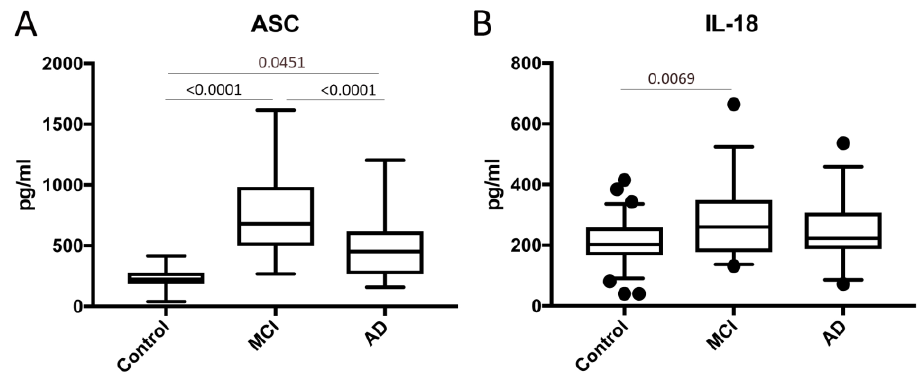
Figure 1. Apoptosis-associated speck-like protein containing a caspase recruitment domain (ASC) and interleukin (IL)-18 are elevated in the serum of patients with mild cognitive impairment (MCI) and Alzheimer’s disease (AD). Protein levels in pg / mL for ASC ( A ) and ( B ) IL-18 in the serum from patients with MCI, AD and controls. ASC: n = 66 control, 32 MCI and 31 AD. IL-18: n = 69 control, 31 MCI and 32 AD. Box and whiskers are shown for the 5th and 95th percentiles.